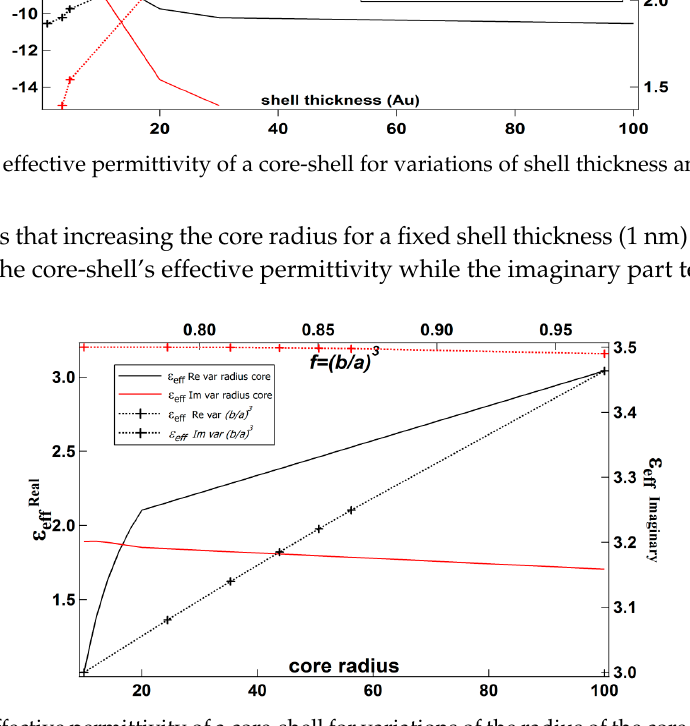
Figure 5. The effective permittivity of a core-shell for variations of the radius of the core and f = ( b / a ) 3 . If the core-shell’s permittivity is viewed only from the (cid:1858) = ((cid:1854) (cid:1853)⁄ ) (cid:2871) variation, it shows that the increase of (cid:1858) = ((cid:1854) (cid:1853)⁄ ) (cid:2871) leads to an increase in the real and imaginary parts of the effective